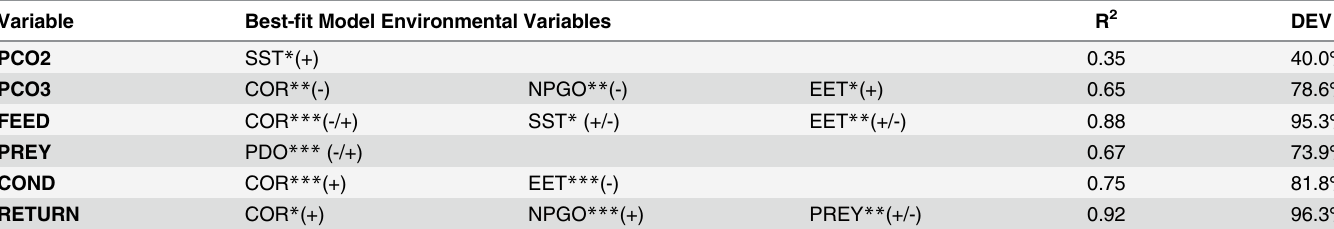
Table 2. General additive models of May salmon biological and environmental variables. Variable